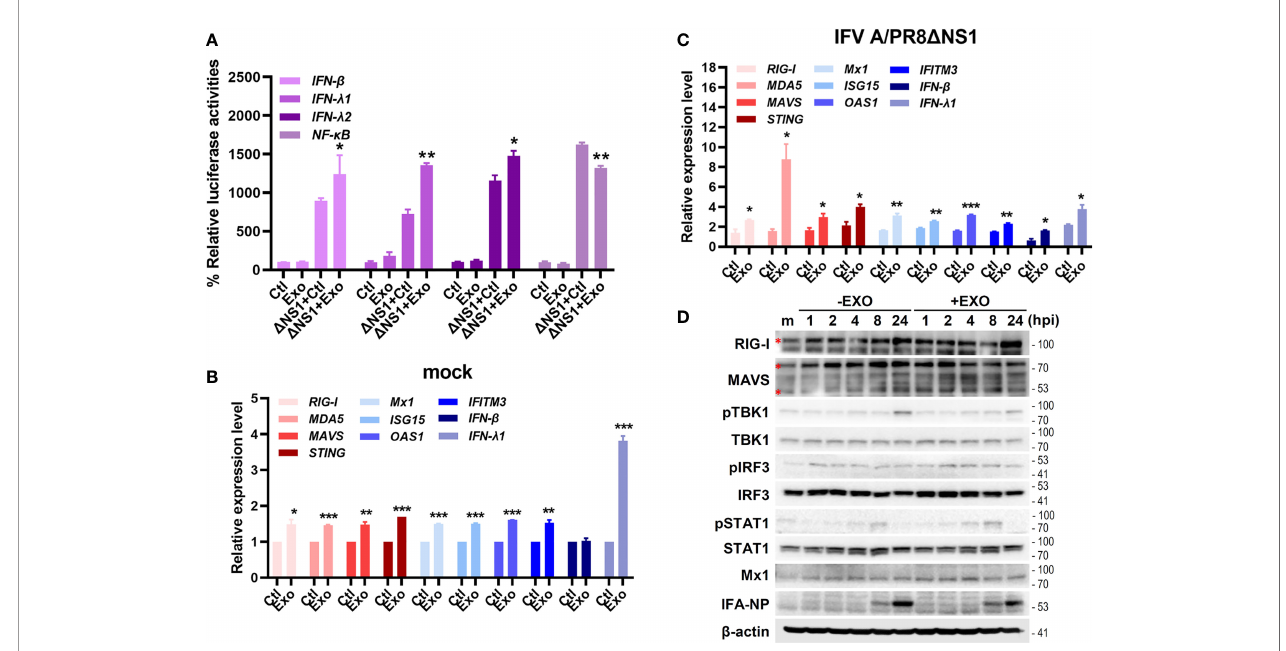
FIGURE 4 | U-exo treatment enhances antiviral interferon (IFN)-mediated signaling and IFN-stimulated genes (ISGs) expression. (A) A549 cells were transfected with the indicated promoter ( IFN- b , IFN- l 1, IFN- l 2 and NF- k B )-driven fi re fl y luciferase plasmids and a constitutively active Renilla luciferase construct (pRL-TK) for 24 h, followed by the infection with mock or IFV A/PR8delNS1 at an MOI of 1. Six hours later, cell lysates were harvested and subjected to luciferase assay. Values are expressed as mean of two independent experiments. (B, C) A549 cells were infected with mock (B) or IFV A/PR8delNS1 (C) at an MOI of 1. After viral attachment, cells were treated with control (Ctl), U-exo (Exo) for 4h, after which host gene expression levels were measured using RT-qPCR. Data are shown as the mean ± standard deviation (SD) of the means from two independent experiments. *p < 0.05; **p < 0.01; ***p < 0.001, vs. Ctl-treated cells. (D) The protein levels of RIG-I, MAVS, phospho-TBK/total TBK, phospho-IRF3/total IRF3, phospho-STAT1/total STAT1, Mx1 and IFV A NP were measured by immunoblot